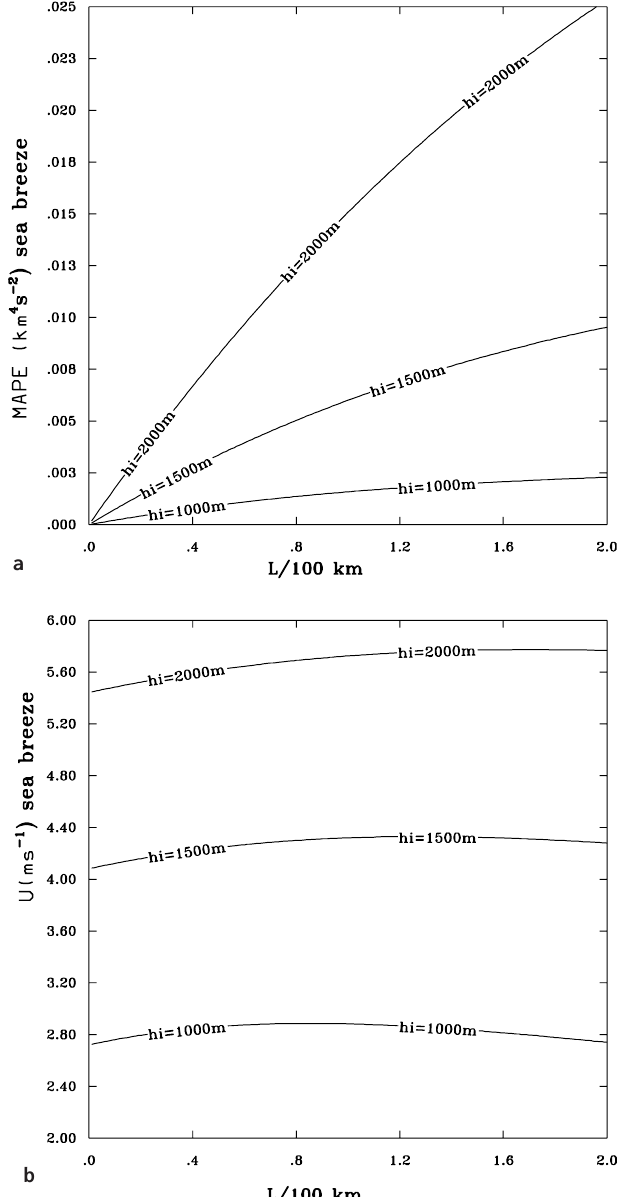
Fig. 4. a Mesoscale available potential energy for the sea-land contrast shown in Fig. 3a, b. The three curves refer to h i (cid:136) 1000 m, h i (cid:136) 1500 m, h i (cid:136) 2000 m. L as in Fig. 3a. b Mean wind velocity for the sea-land contrast shown in Fig. 3a, b. The three curves refer to